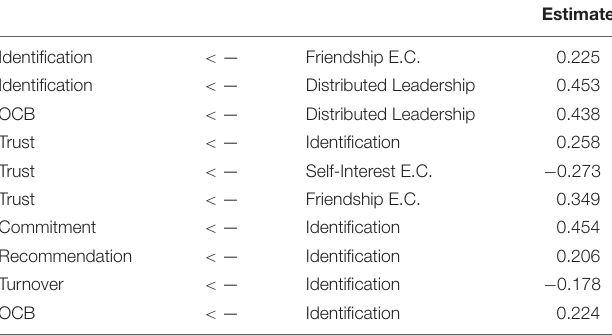
TABLE 2 | Standardized path coefficient (regression weights) of the tested